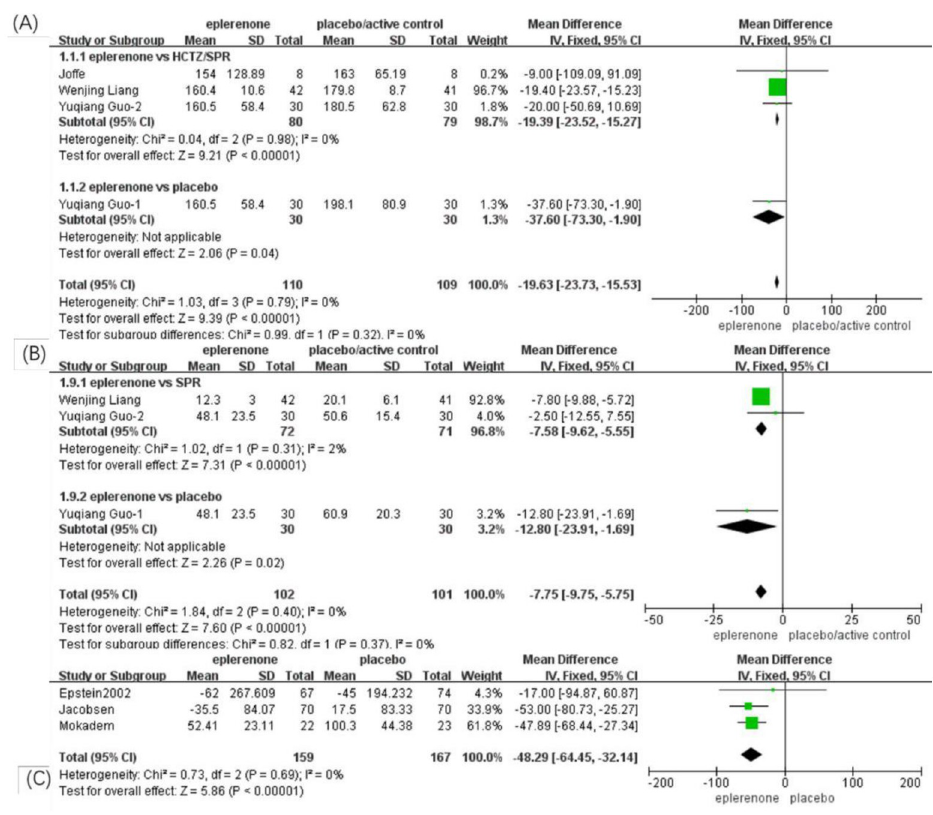
Fig 3. Forest plots of the effects on urinary albumin or protein excretion between the eplerenone treatment groups and the controls. (A) Effect on 24-h Proteinuria in articles comparing eplerenone to placebo/active control. (B) Effect on microalbuminuria in articles comparing eplerenone to placebo/active control. (C) Effect on UACR for the eplerenone versus placebo.